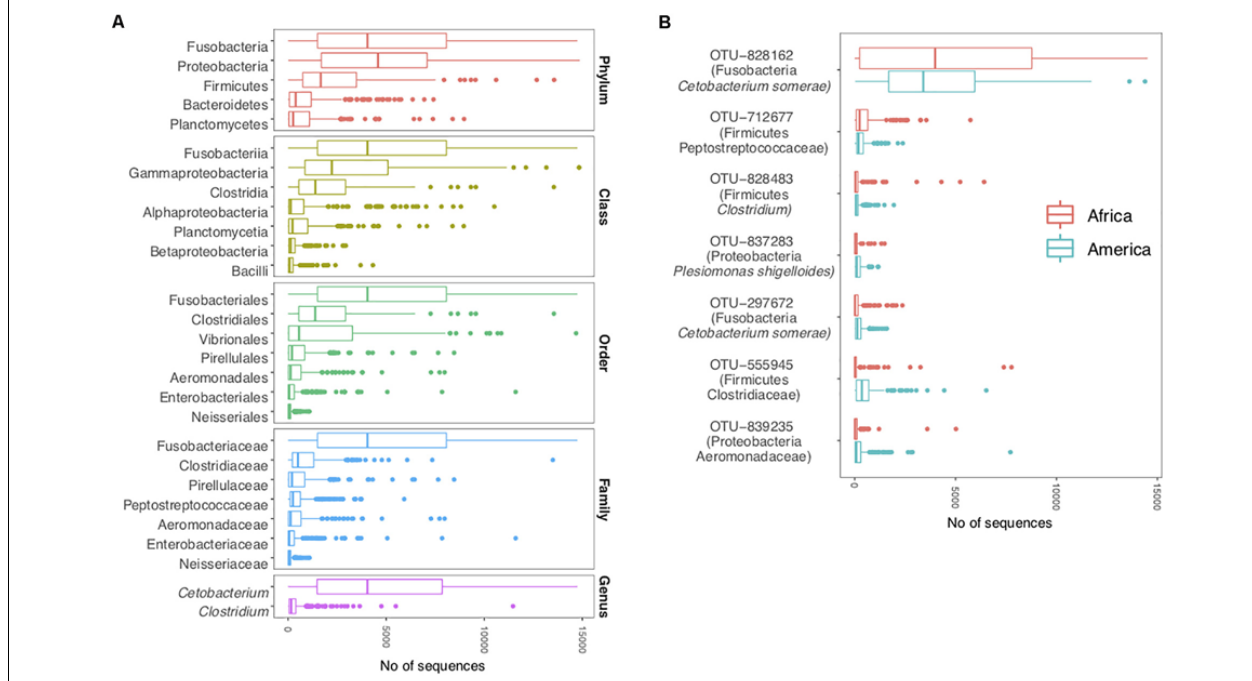
FIGURE 2 | The cichlid core microbiota (each taxon shared by at least 90% of the specimens). (A) Core taxa per individual taxonomic levels (from phylum to genus) and overall abundances across all specimens (sequence counts were binned by taxonomic rank). (B) Core OTUs and abundances separately for each continent. OTUs are shown along with their taxonomic classification assigned with a confidence ≥ 80% against the Greengenes database (phylum is followed by the highest taxonomic resolution achieved). Boxplots are centered at the median and whiskers show data dispersion across specimens. The analyses are based on the rarefied dataset